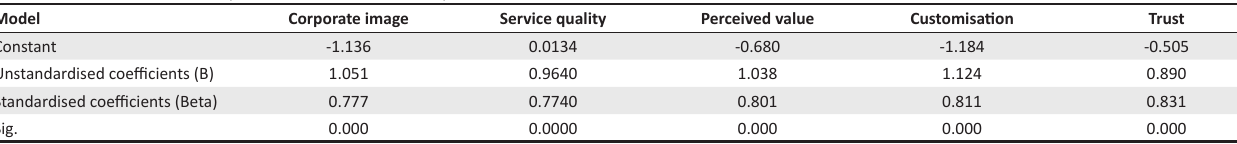
TABLE 3c: Influence of the independent variables on the dependent variable. Coefficients. Model